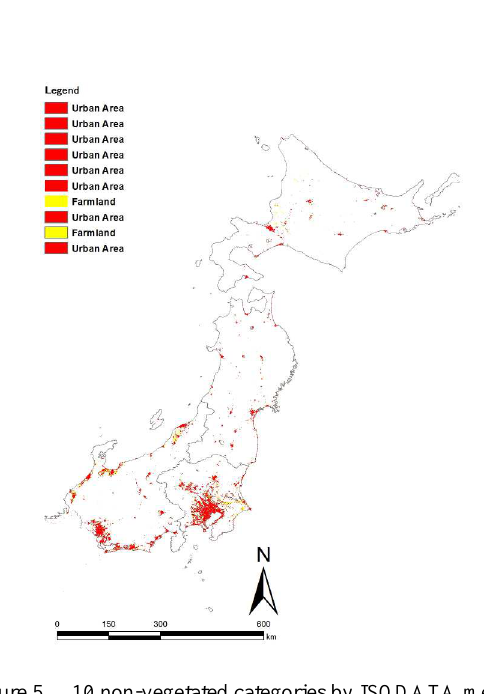
Figure 5. 10 non-vegetated categories by ISODATA method classification of Terra/MODIS data